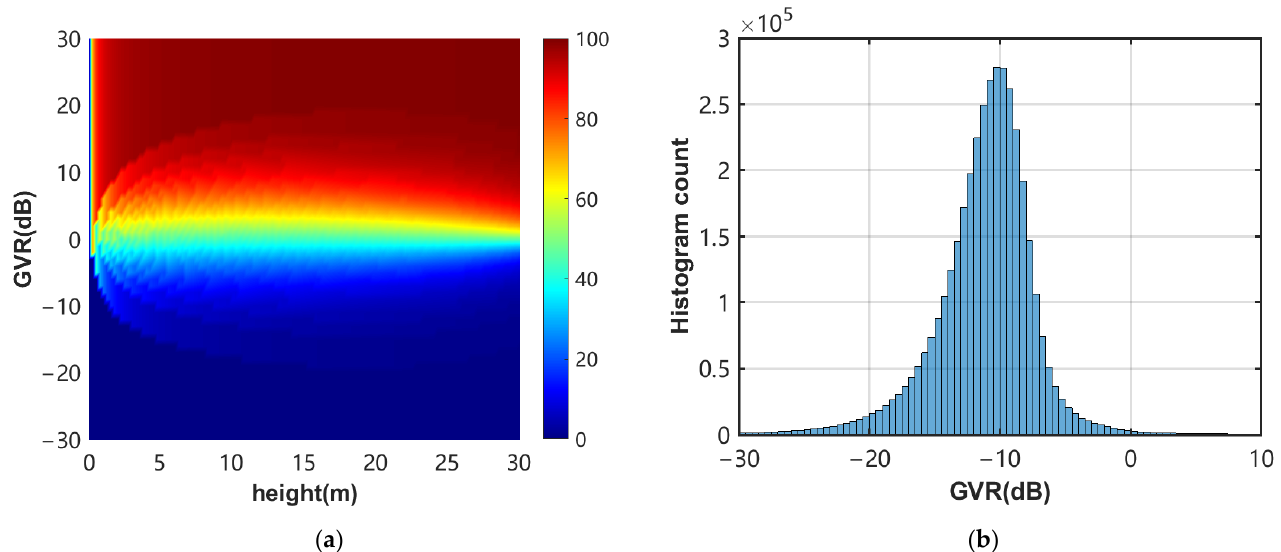
Figure 13. ( a ) Forest height deviation map based on the assumption of zero GVR and ( b ) the histogram of GVR after the improvement of the 0711-0725 interference pairs.